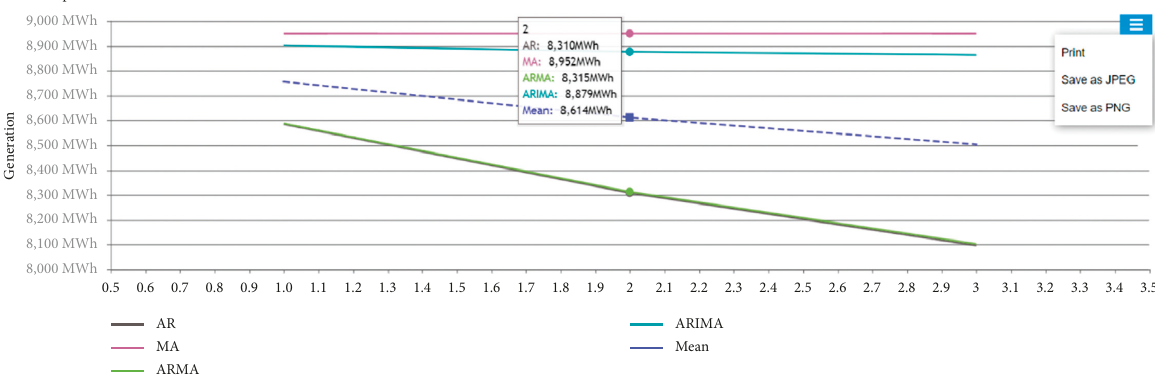
Figure 6: Multilinear graph for a medium-term time horizon.